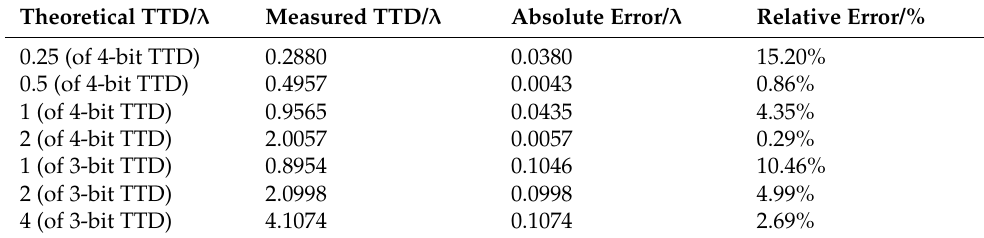
Table 1. Measurement results of 7-bit TTD and accuracy of each state.